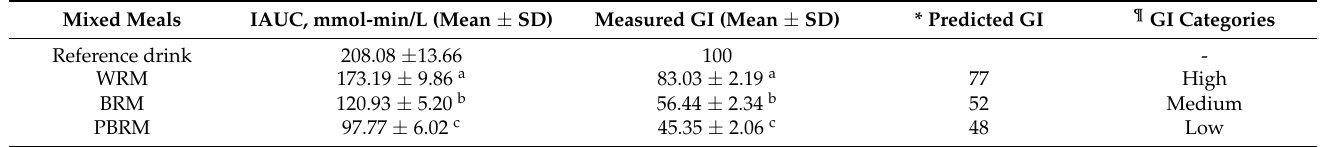
Table 3. IAUC and GI of meals of different varieties of rice measured using the real-time continuous glucose monitoring system (rtCGM).